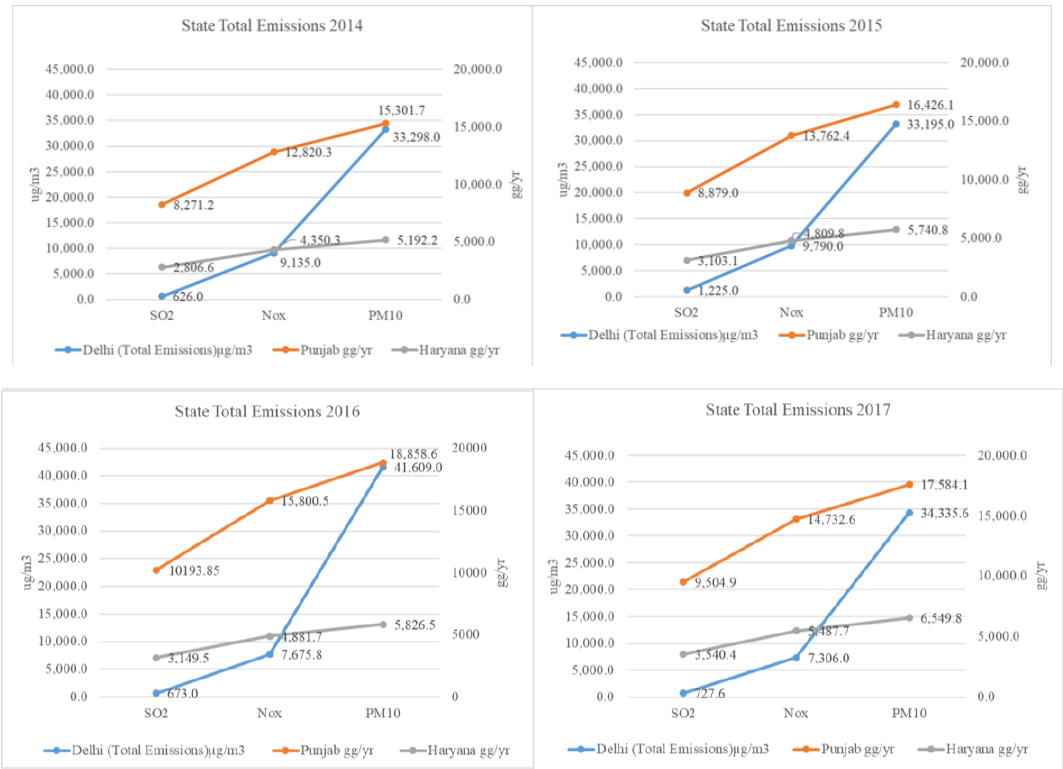
Figure 2: Comparison of total emissions from 2014 to